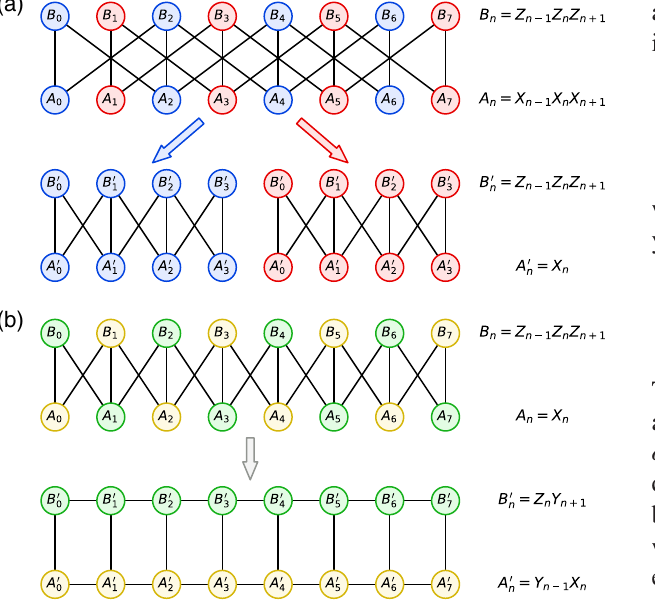
FIG. 13. Frustration graph reveals equivalence between differ- ent measurement ensembles. (a) The frustration graph for the ensemble E 1 ¼ f Z 0 Z 1 Z 2 ; X 0 X 1 X 2 g has two connected compo- nents, highlighted by the color scheme. Separating the two yields two copies of ensemble E 2 ¼ f Z 0 Z 1 Z 2 ; X 1 g . (b) The ensemble E E 2 is, in turn, equivalent to 3 ¼ f Z 0 Y 1 ; Y 0 X 1 g via a permutation of vertices, as highlighted by the color